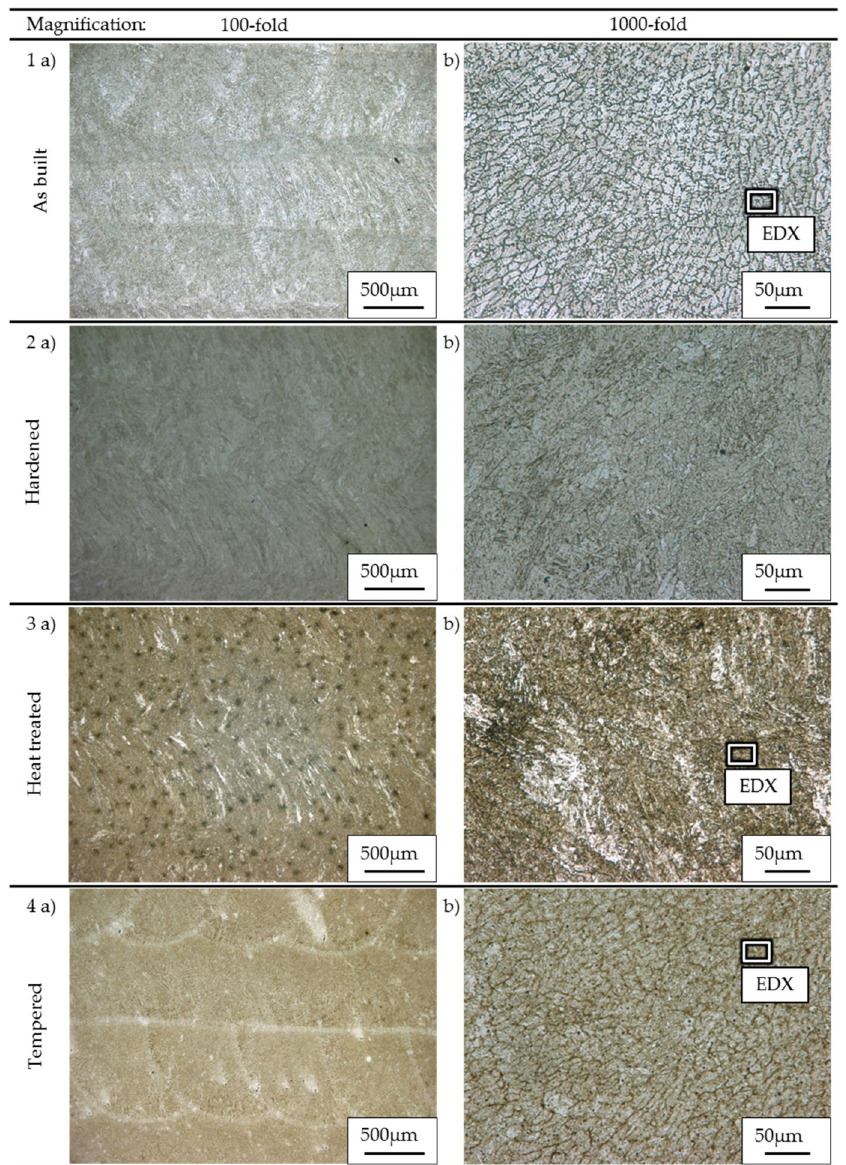
Figure 8. Microstructure of additively-manufactured hot work tool steel X37CrMoV5-1 after different heat treatments analyzed on cross sections etched with V2A-mordant for 15 s. The microscopic analysis is depicted with ( a ) 100-fold and ( b ) 1000-fold magnification for the different heat treatment conditions of ( 1 ) no heat treatment (as built), ( 2 ) austenitization and quenching, ( 3 ) conventional heat treatment and ( 4 ) three times tempering without